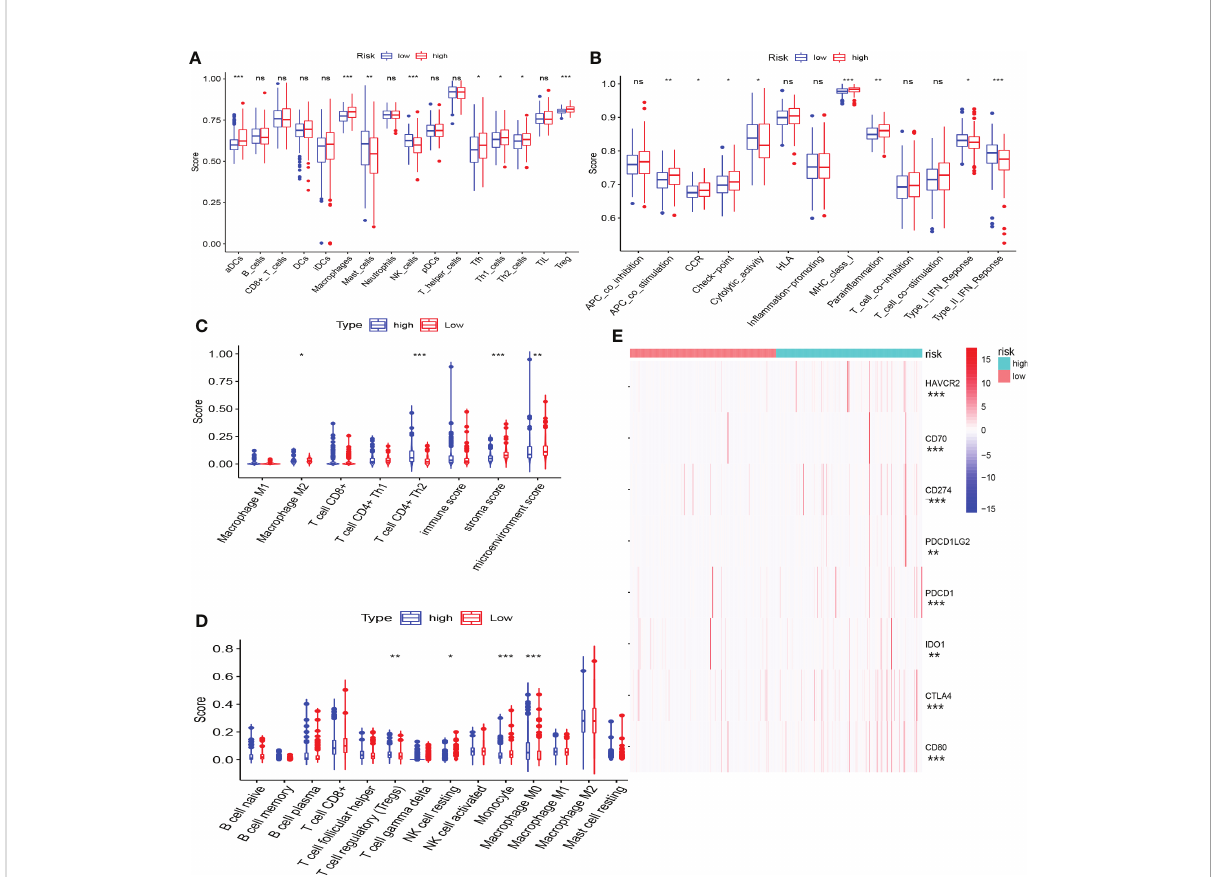
FIGURE 8 The correlation between CRFs and immune features. (A) Comparison of immune cell in fi ltration in high- and low-risk groups using single- sample gene set enrichment analysis. (B) Comparison of immune function in high- and low-risk groups using gene set enrichment analysis (GSEA). (C) Comparison of immune cell in fi ltration in high- and low-risk groups using xCELL. (D) Comparison of immune cell in fi ltration in high- and low-risk groups using CIBERSORT. (E) Comparison of the expression level of common immune checkpoints in high- and low-risk groups. (*, **, ***, and ns represent p < 0.05, p < 0.01, p < 0.001, and “ not statistically ”